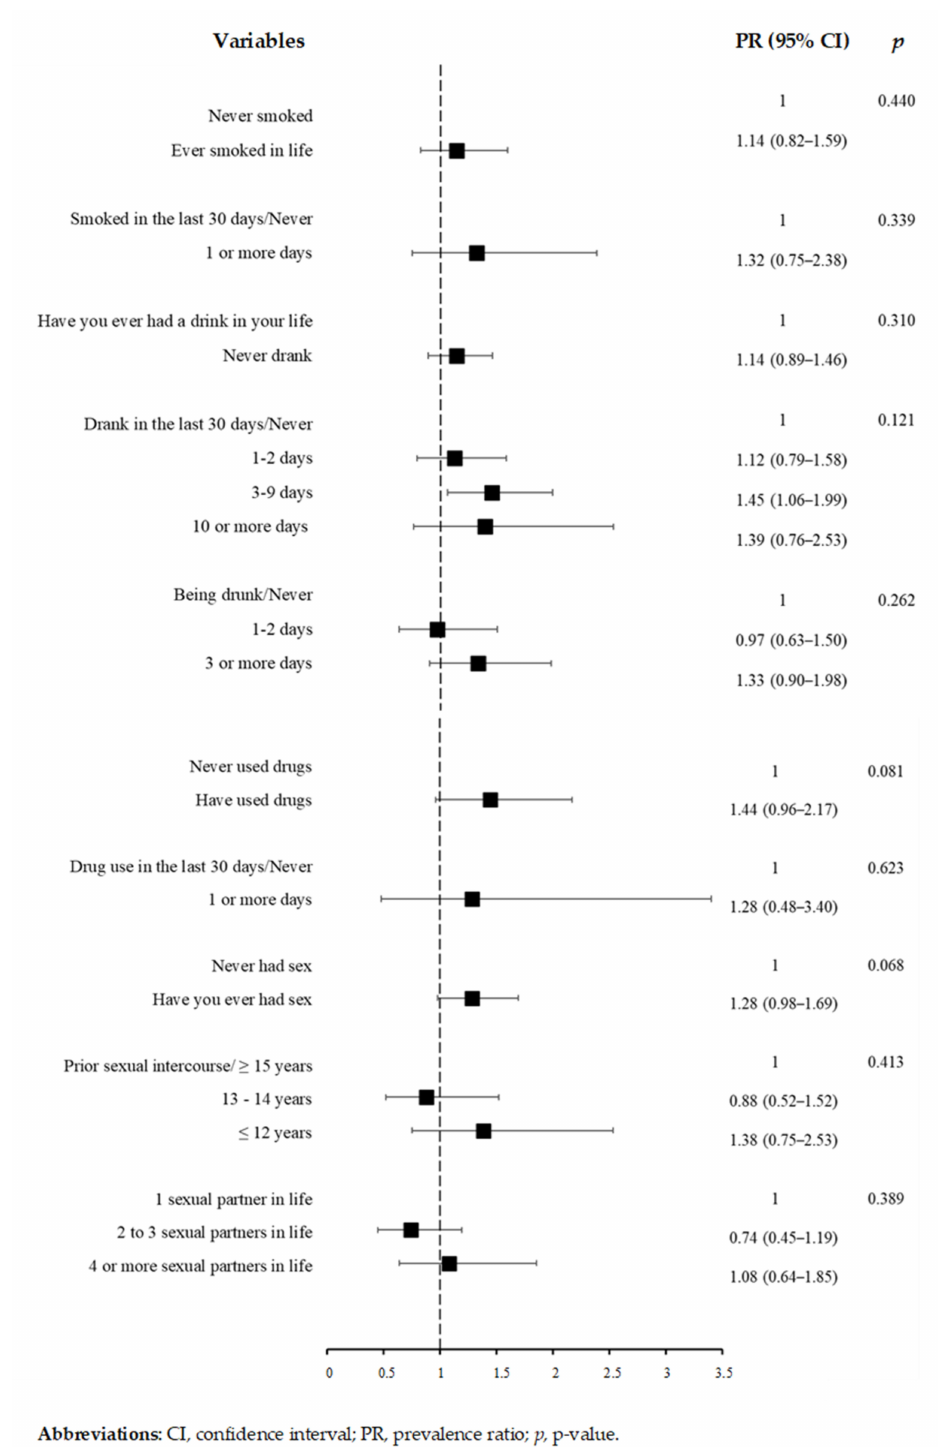
Figure 3. Poisson regression results for depressive symptoms and variables related to psychoactive substance use and sexual behavior ( n =